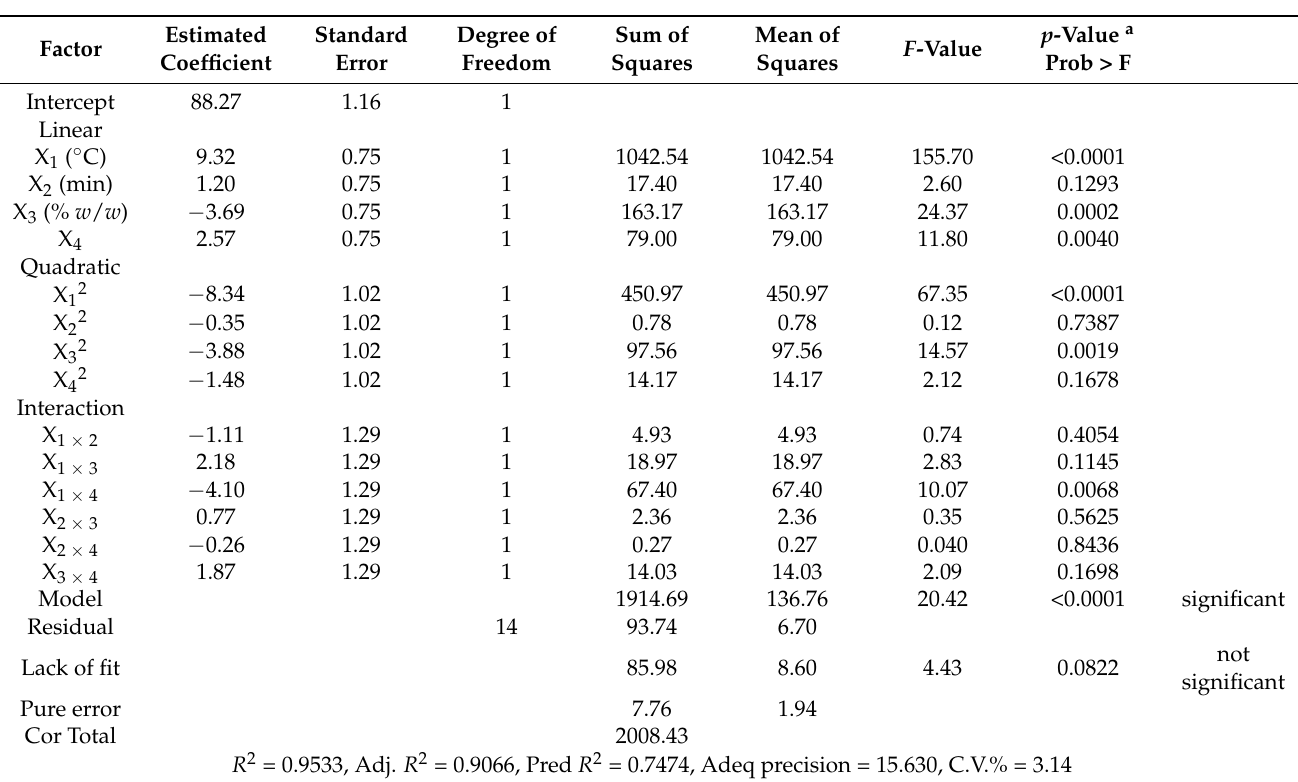
Table 3. Estimated regression coefficients for the quadratic polynomial model and the analysis of variance (ANOVA) for the experimental